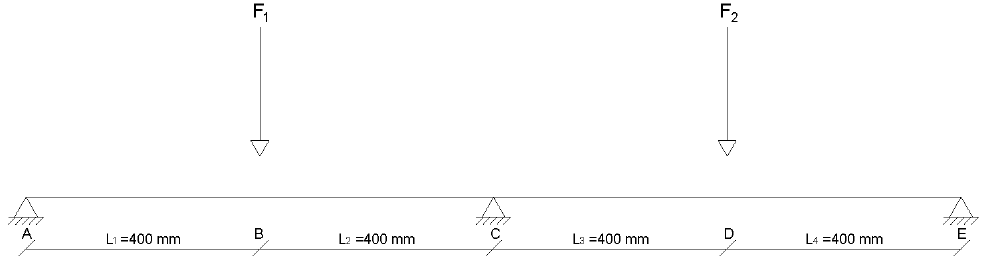
Figure 2. Structural scheme, loading position, and constraints.